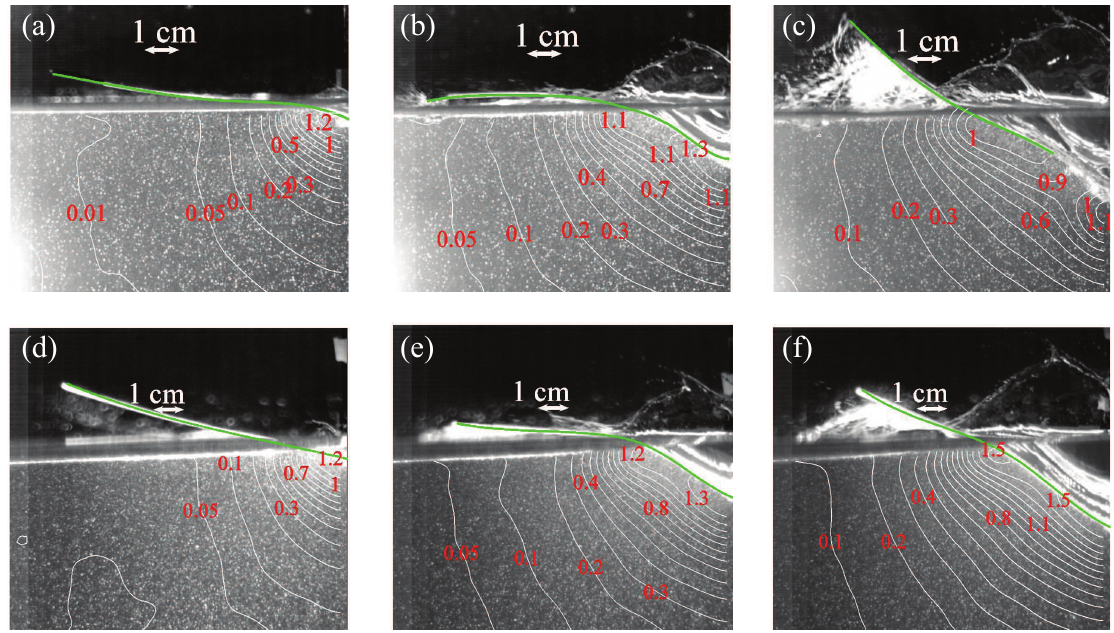
Figure 3. High-speed images overlaid with velocity magnitude in m/s for ( a – c ) Light-High and ( d – f ) Heavy-High conditions, at different time instants: ( a , d ) t = 1.25 ms; ( b , e ) t = 7.5 ms; and ( c , f ) t = 12.5 ms. The green line identifies the panel